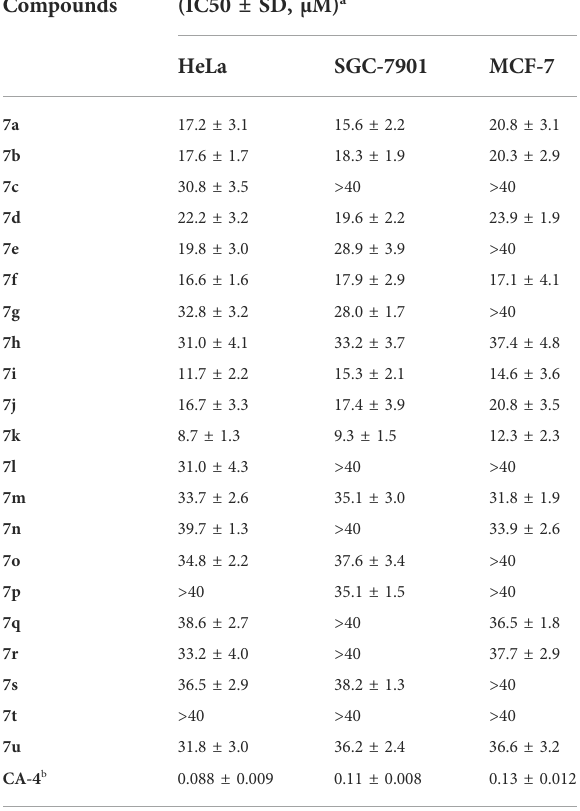
TABLE 1 Anti-proliferative activity of all target compounds. Compounds